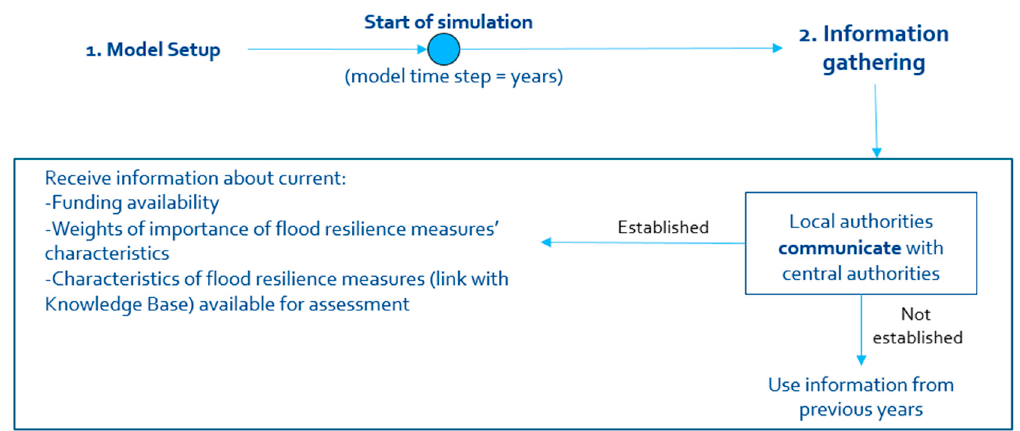
Figure 4. Procedure for information gathering.